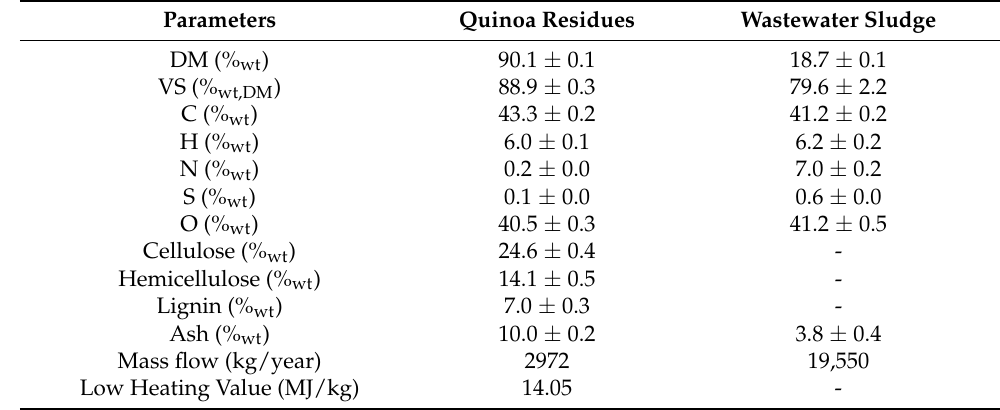
Table 2. Elemental and proximate analysis, polymeric composition, and low heating value of the biomasses. The proximate analysis provides the weight percentages (%wt) of the dry matter (DM) and volatile substances (VS). The characterization of the biomasses is taken from Ref. [6] to allow a direct comparison of the results of the present